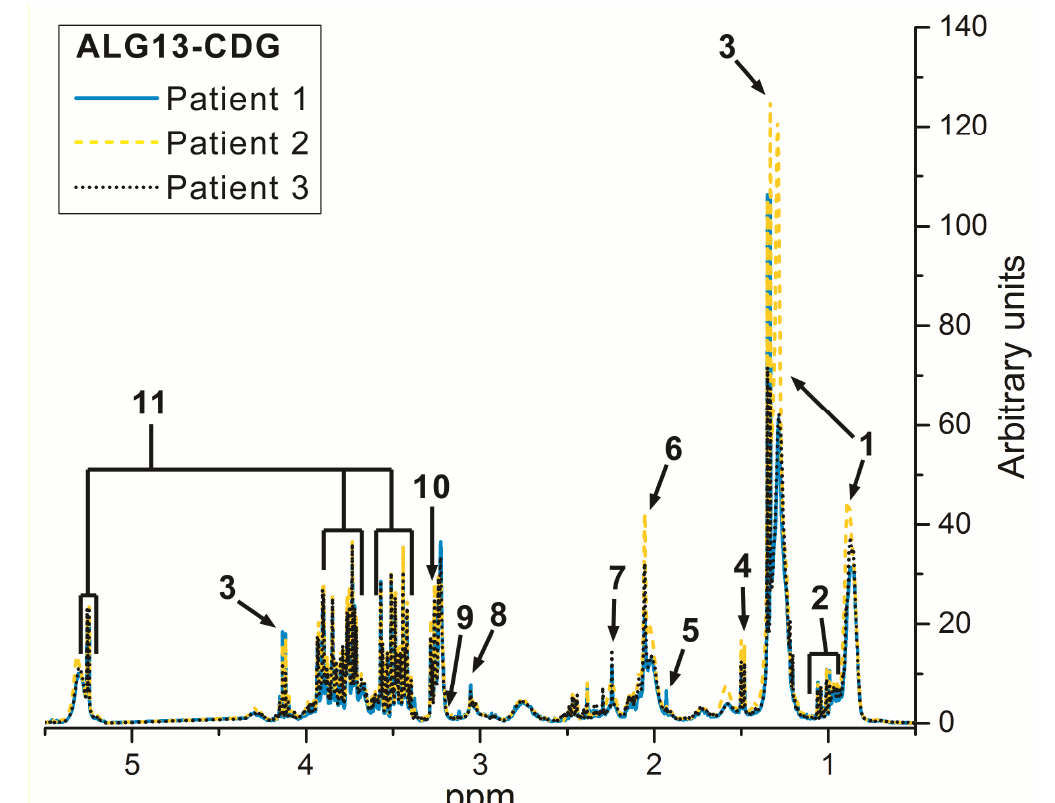
Figure 1. 1H-NMR Carr–Purcell–Meiboom–Gill (CPMG) spectra of the serum samples obtained from three ALG13 c.320A>G carrier patients: Patient 1—blue line, Patient 2—yellow dashed line, Patient 3—black dotted line. The main detected metabolites are: 1, lipids; 2, BCAA (branched-chain amino-acids); 3, lactate; 4, alanine; 5, acetate; 6, NAG (N-acetyl-glycoprotein); 7, acetone; 8, creatinine; 9, carnitine; 10, betaine; 11, glucose.